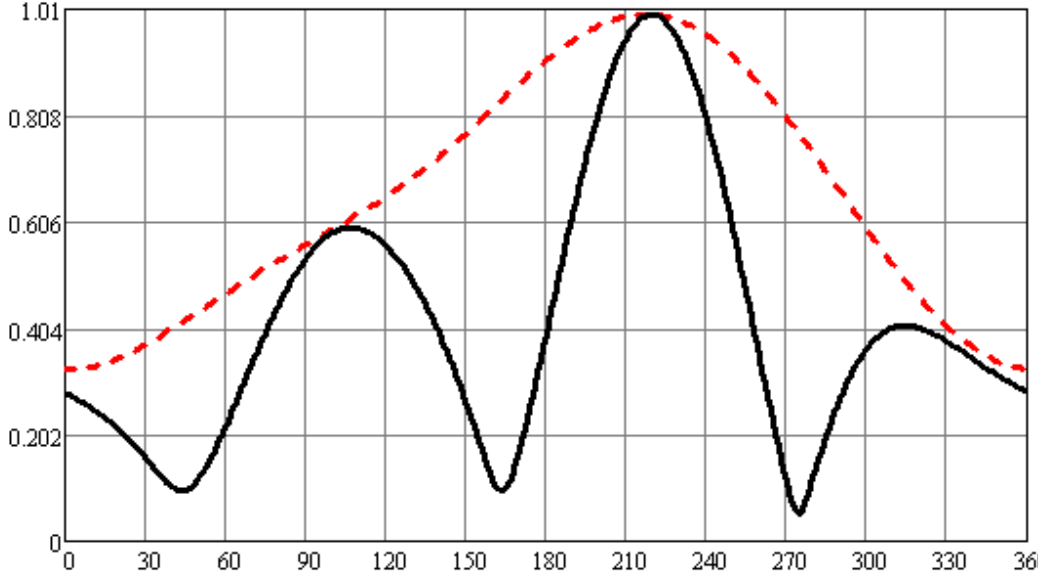
◦ and α = 220 ◦ ; VAA radius is 1.25 m; N = 2